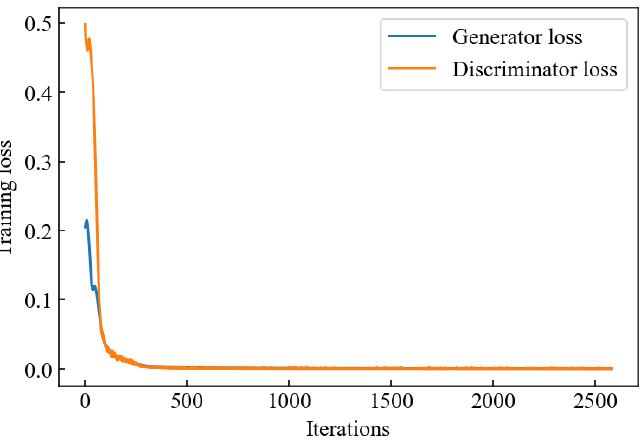
Figure 6. The training process of LSTM-GAN with a sample size of 10 × 24.